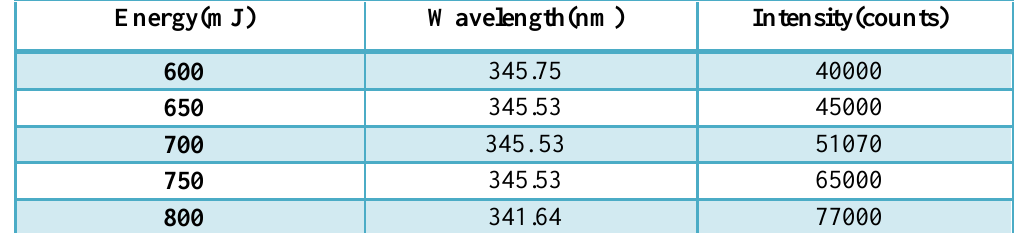
Table 2: The laser parameters used in the second group at (10 Hz) repetition rate with wavelength and